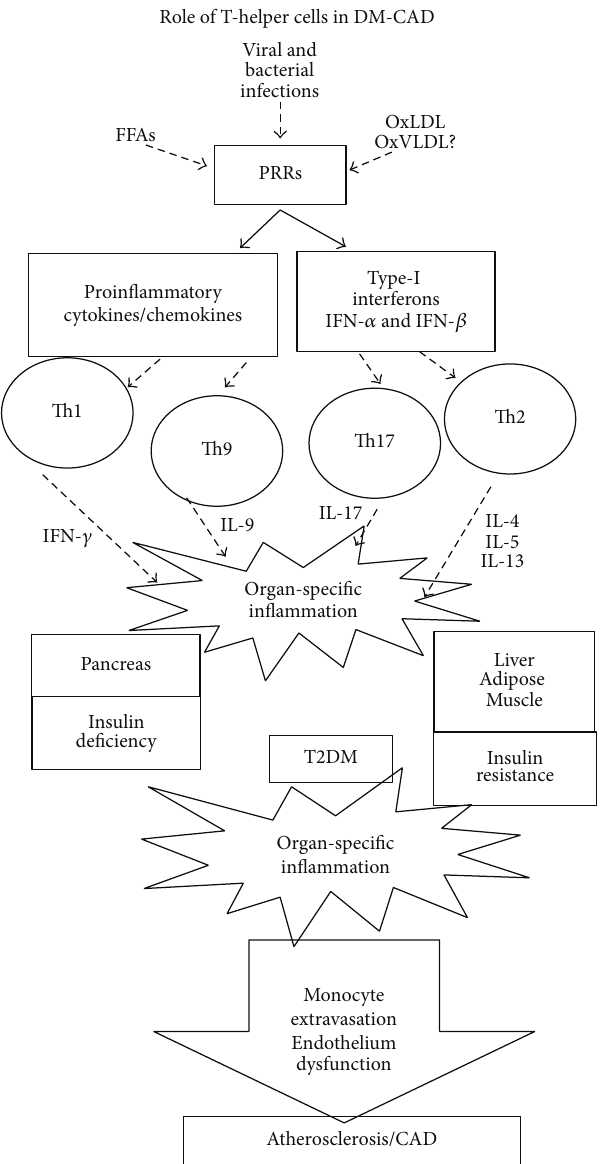
Figure 2: Role of adaptive immune response in triggering metain- flammation associated with DM-CAD. CD4 + T-helper cells are the most well characterized work horses of the adaptive immune system which trigger metainflammation. Inflammation triggered by PRRs is translated to T cells by the APC-T cell interaction which results in the recruitment of these activated cells into pancreases, adipose, liver, and skeletal muscle reinforcing the metainflammation set by PRRs. Depending upon the relative proportions of these cell types pancreatic beta cell apoptosis and IR in insulin target tissues can get aggravated precipitating in Type-2 Diabetes. Long standing diabetes induces systemic inflammation leading to monocyte activation and endothelial dysfunction leading to the extravasation of monocytes and formation of atherosclerotic